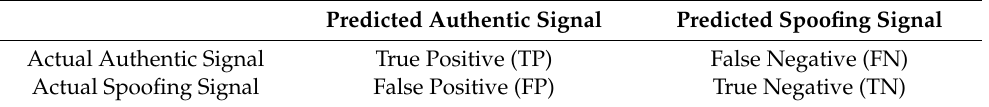
Table 4. Confusion matrix.